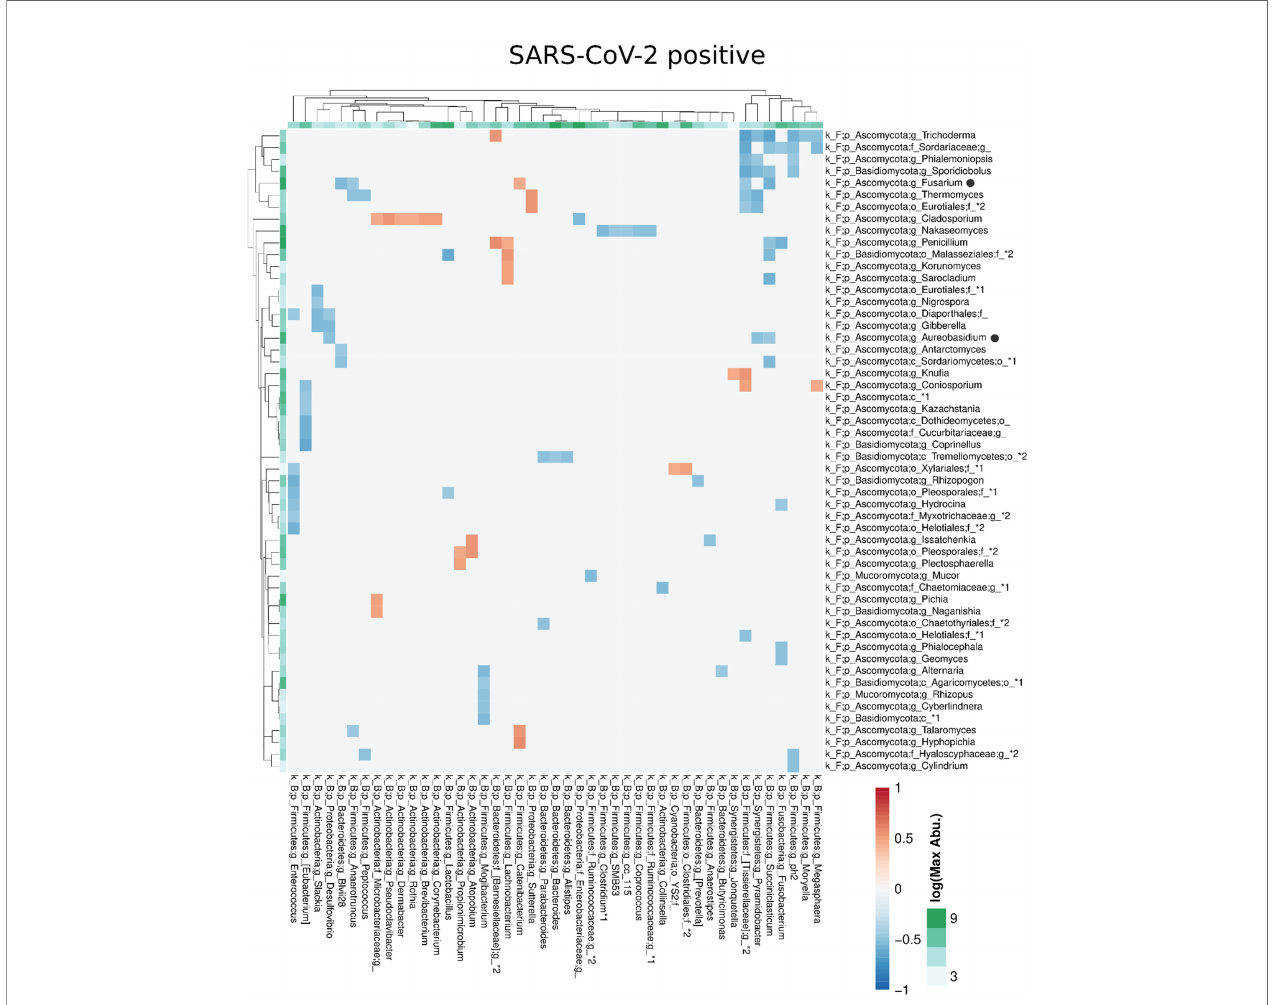
FIGURE 7 | Co-occurrence matrix visualizing the co-occurring genera between the fungal and bacterial kingdoms that exhibit positive (red) or negative (blue) correlations in SARS-CoV-2 positive patients. The colours of the scale bar denote the strength of the correlation with 1 indicating a perfect positive and -1 a strong negative correlation between the two co-occurring genera. The sidebars show the logarithm of the maximum abundance of the genera in the group. When two genera with the same taxonomy assignment were present that could only be identi fi ed to the family level or above this level, an asterixis and an identi fi er number was added to the name to distinguish the taxa. Black circles following the genus names indicate the genera which are discussed in the